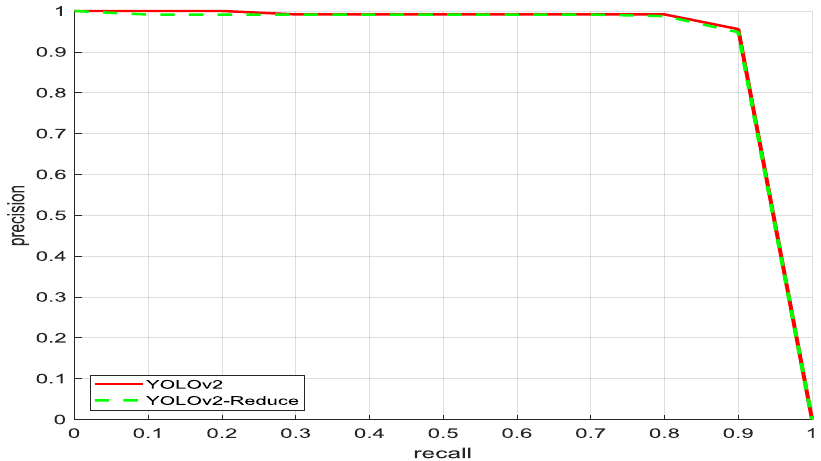
Figure 10. Precision recall curve for YOLOv2 and YOLOv2-reduced on the SSDD dataset.